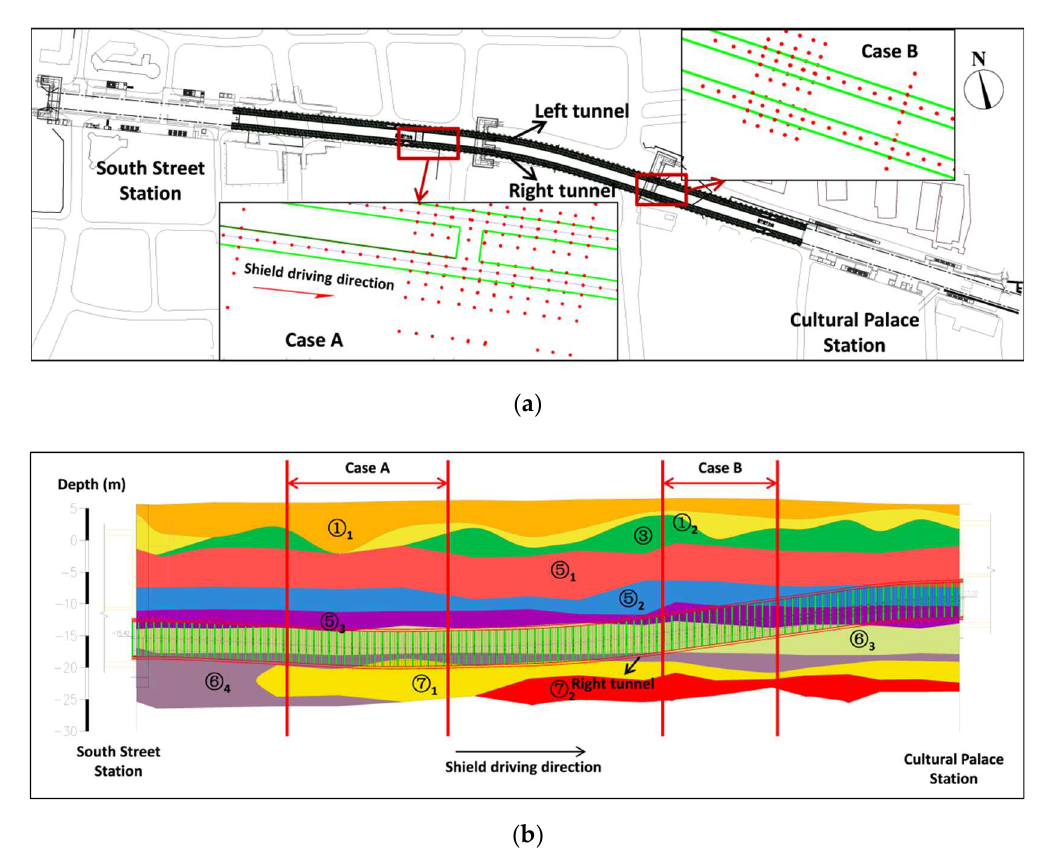
Figure 8. Shield tunnel between South Street station and Cultural Palace station. ( a ) plan view, ( b ) longitudinal tunnel sectional view.